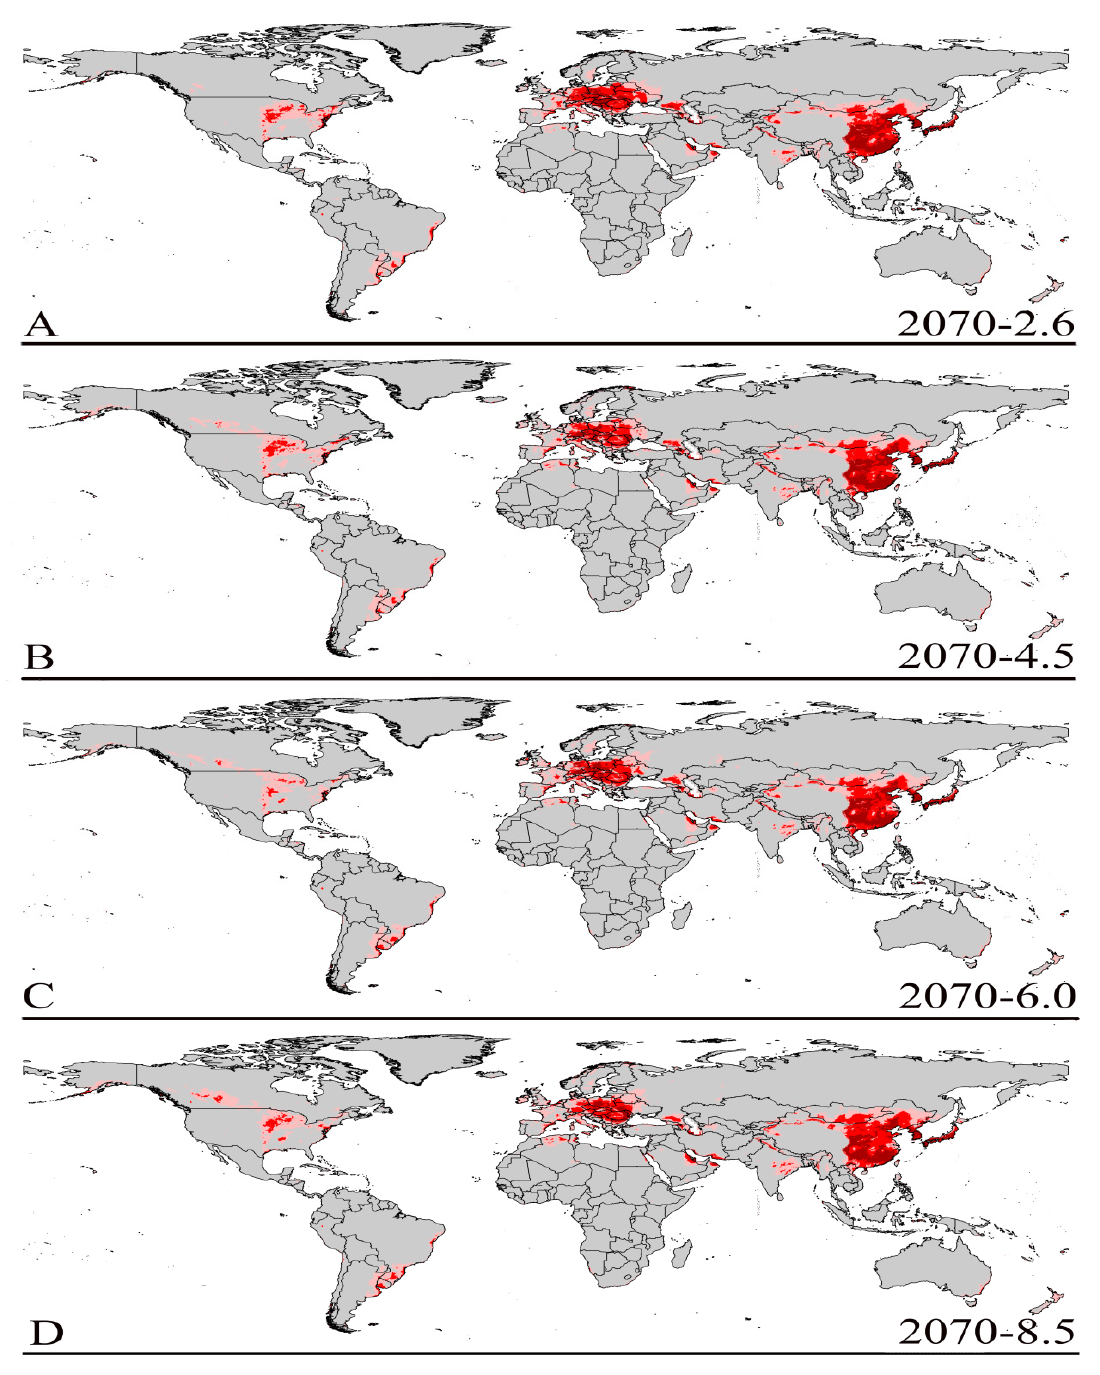
Figure 5. Future distribution models of Pseudaulacaspis pentagona on globe under different climate scenarios predicated by MaxEnt. Gray, unsuitable habitat area; Pale red, low habitat suitability area; Red, moderate habitat suitability area; Dark red, highly habitat suitability area. RCP: Representative Concentration Pathway. ( A ) RCP 2070-2.6; ( B ) RCP 2070-4.5; ( C ) RCP 2070-6.0; ( D ) RCP 2070-8.5.